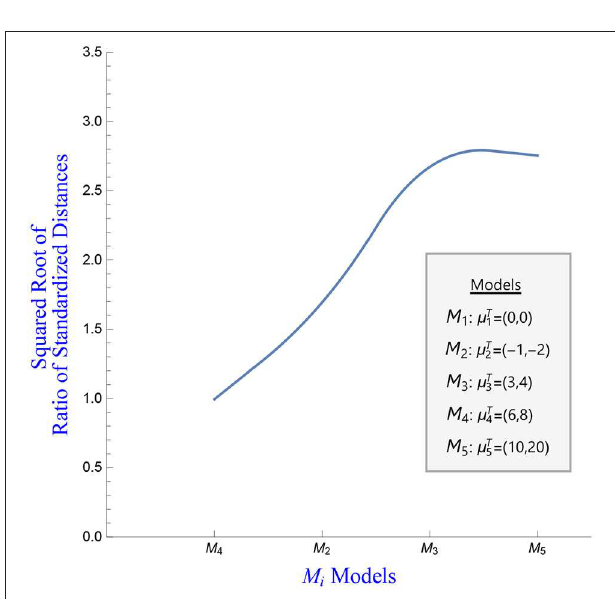
FIGURE 4 | Squared root of the standardized estimates of the distances between model ˆ F and the various fitted models. FIGURE 5 | Squared root of the ratio of the standardized distance vs. the